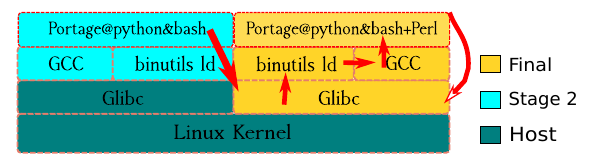
Figure 2. Installation steps of a Gentoo Prefix on a GNU / Linux host.